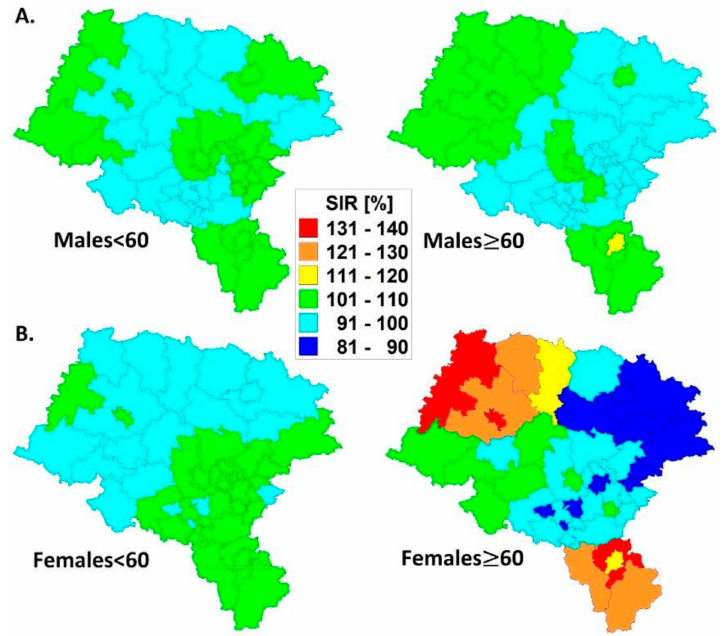
Figure 3. SIRs of cutaneous malignant melanoma in age groups (<60 and ≥ 60) in males (Panel ( A )) and females (Panel ( B )) in Upper Silesia, Poland (2004–2013).